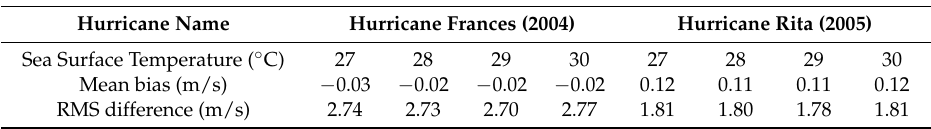
Table 2. Errors between H*wind analysis data and the retrieved wind speeds using the Klein-swift model with different fixed sea surface temperatures.